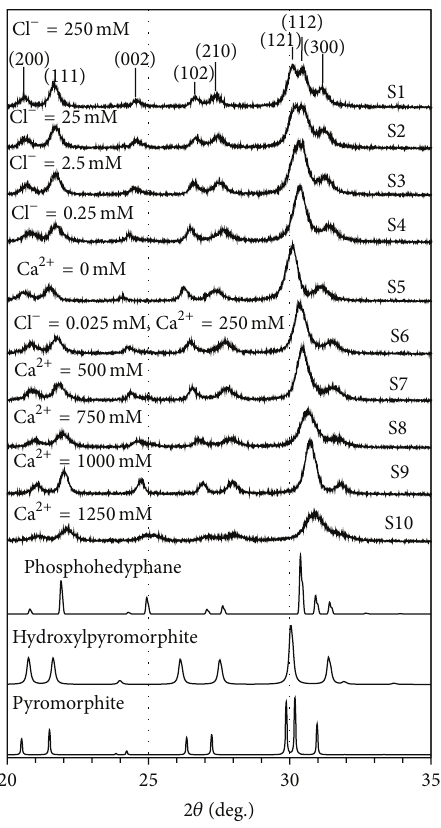
Figure 5: Synthetic apatites. X-ray powder diffraction patterns of synthetic calcium lead apatites S1–S10. The Miller indices are shown for sample S1.